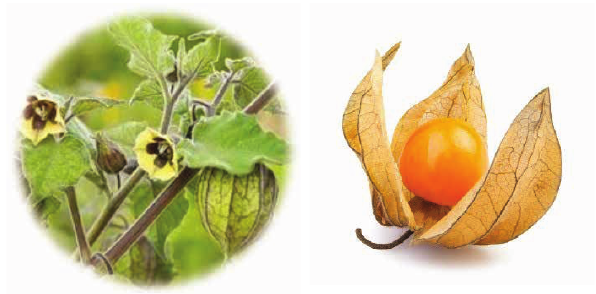
Figure 1: Physalis peruviana bush and fruit (Oliveira